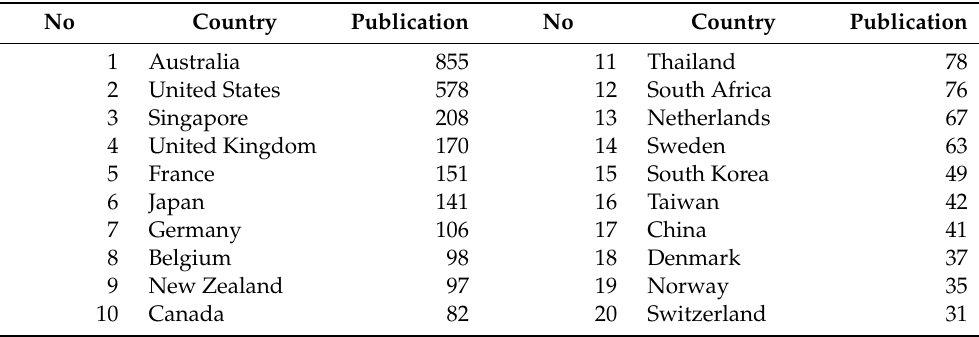
Table 3. Top 20 countries in Vietnam research collaboration network during the period from 2008–2019 (last updated 30 April 2020).